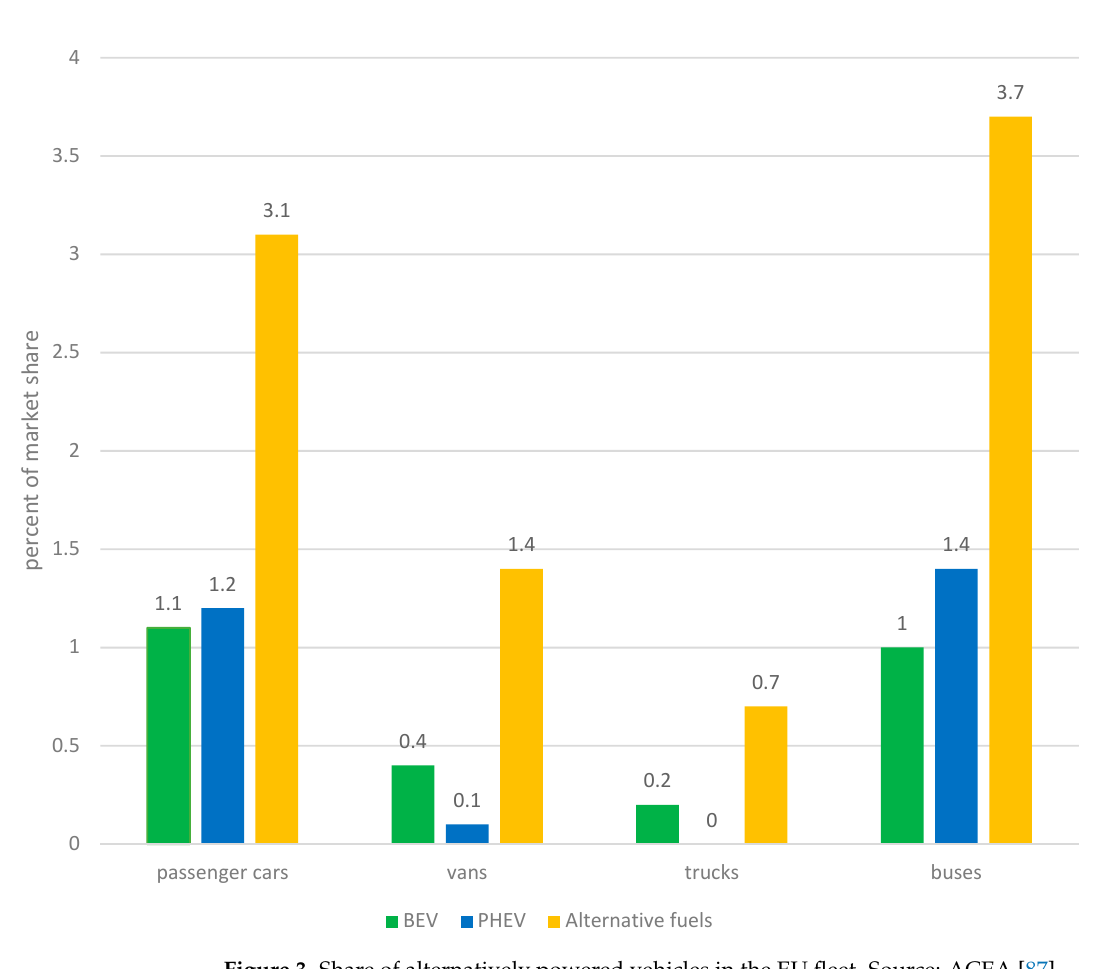
Figure 3. Share of alternatively powered vehicles in the EU fleet. Source: ACEA [87].